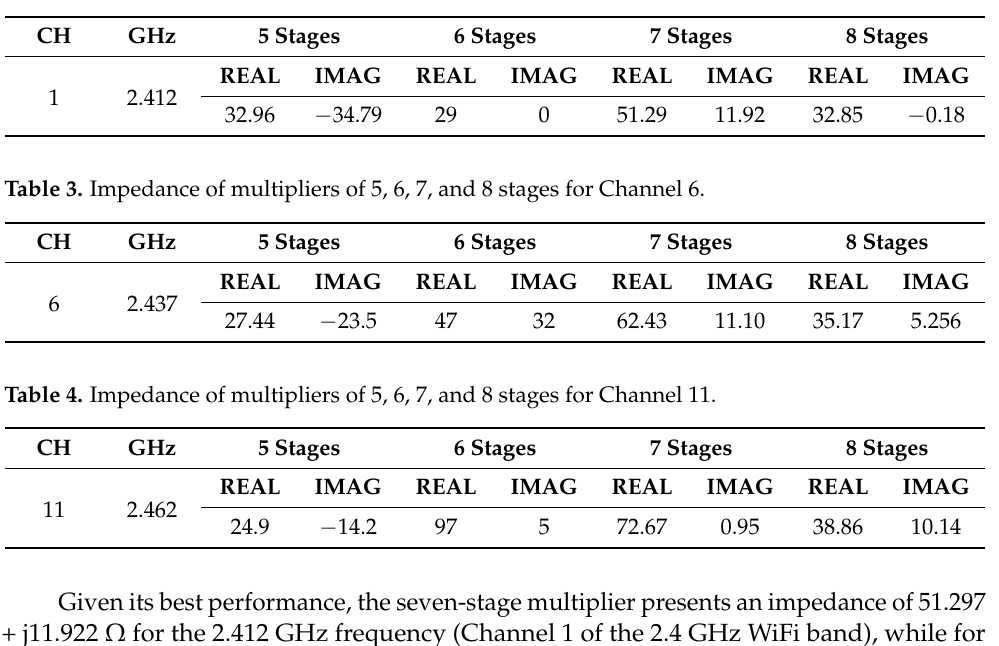
Table 2. Impedance of multipliers of 5, 6, 7, and 8 stages for Channel 1.